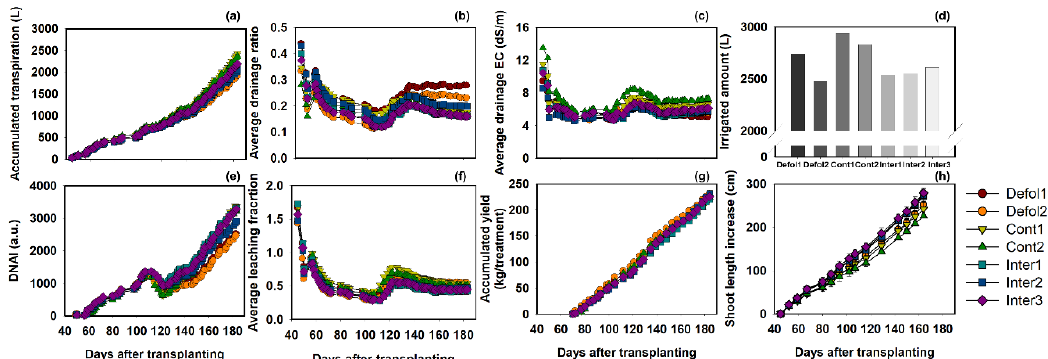
Figure 5. Accumulated transpiration ( a ), average drainage ratio ( b ), average drainage EC ( c ), irrigation amount ( d ), DNAI ( e ), average leaching fraction ( f ), accumulated fruit yield ( g ), and shoot length increase ( h ) during the period of the DNAI estimation experiment.